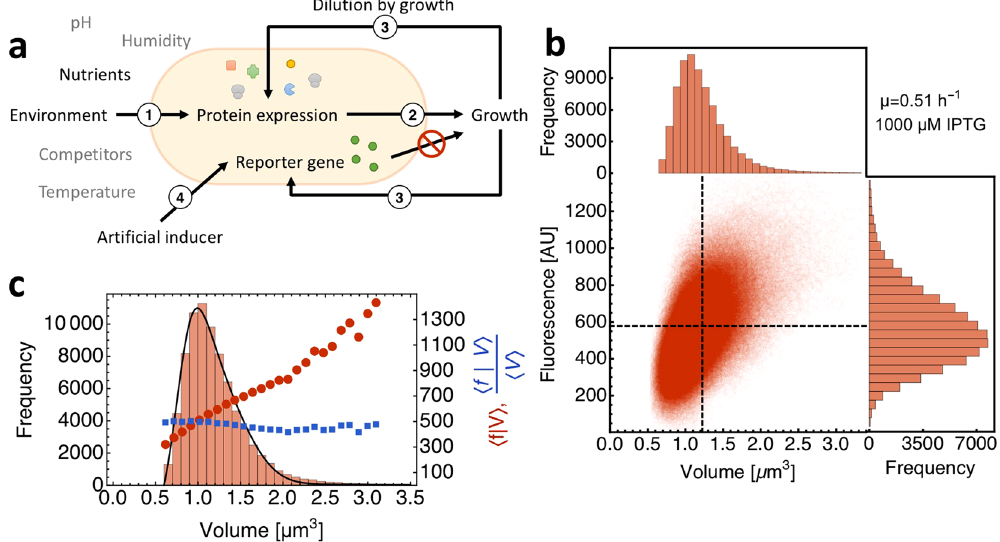
Figure 1. Quantification of the independent effects of growth rate and promoter activity on single-cell protein expression. ( a ) Protein expression in a single cell is set by various factors indicated by the numbered arrows. The environment and cellular control circuits influence protein expression via their influences on transcriptional and translational rates (1). If the protein contributes to growth it exerts an effect on growth rate (2). The resulting physiological state of the cell feeds back onto protein expression (3) via for instance dilution by volume-growth. Usage of a titratable, non-catalytic protein allows for the quantification of growth feedback on protein expression at different promoter activities (4). ( b ) Flow cytometric quantification of single-cell protein expression. For each cell, we measured its total fluorescence and its scatter values, from which we inferred its volume using a cross-calibration of the Coulter counter and the flow cytometer (Fig. S13, details can be found in the ‘Materials and methods’). These data give rise to a distribution of total cell fluorescence, cell volumes and fluorescence concentration, which is analysed in this paper. ( c ) Relationship between the volume, fluorescence and fluorescence concentration of a cell. During balanced growth, cell fluorescence is proportional to volume (red), such that the fluorescence concentration (blue) remains constant across the population and over time. The black line is a fit according to the equation derived by Collins & Richmond 36 to describe the extant volume distribution of exponentially growing